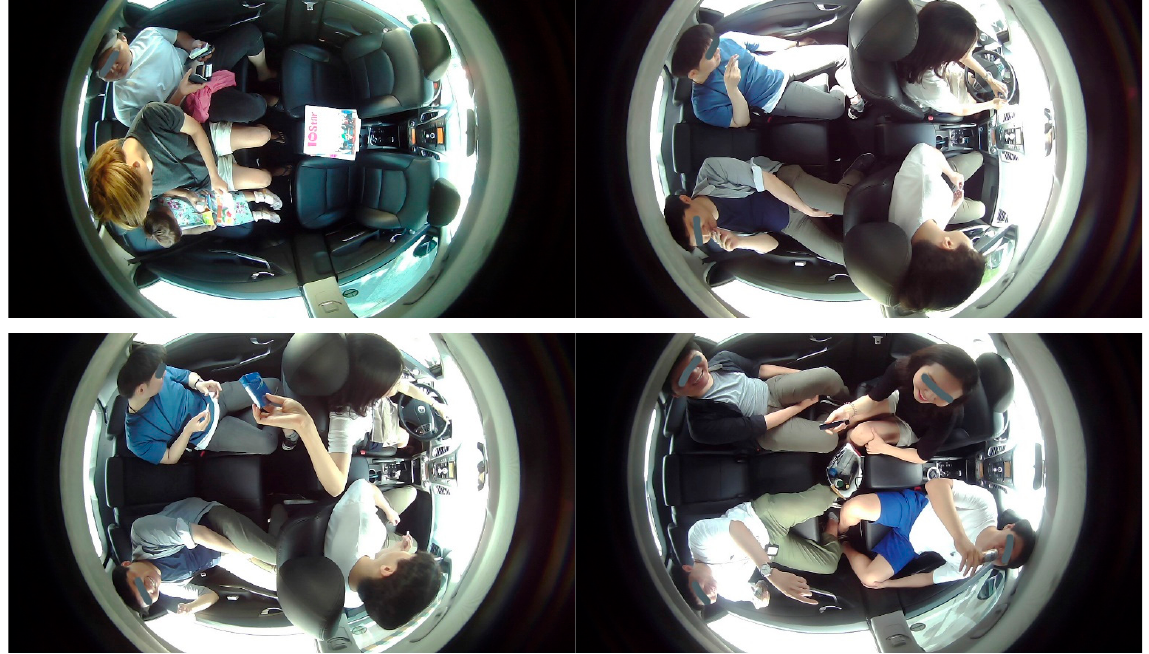
Figure 7. Example images for smoking items inside the cabin of AV.